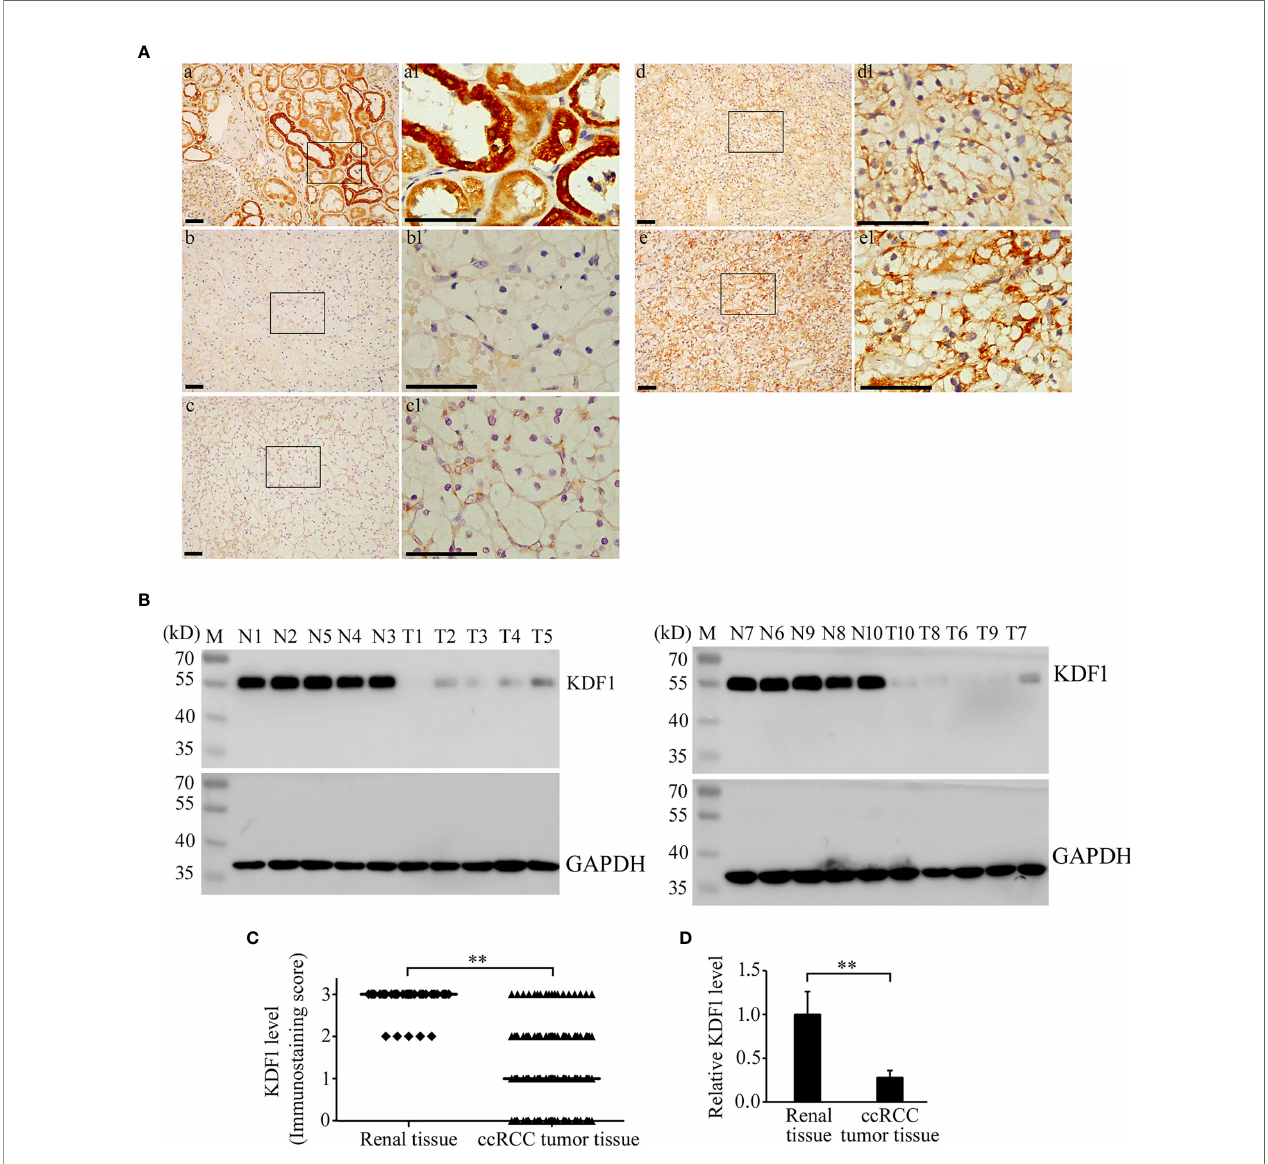
FIGURE 2 | Expression of KDF1 in the tumor tissue of patients with clear cell renal cell carcinoma (ccRCC). Immunohistochemical staining was performed on the tumor tissue of 241 ccRCC patients while 39 non-tumor renal tissue samples were used as controls. The expression of KDF1 in the tumor tissue of 10 ccRCC patients was con fi rmed by Western blot while 10 non-tumor renal tissues were used as controls. (A) Representative pictures of immunohistochemistry. a: A representative picture from non-tumor renal tissue; b: A representative picture from ccRCC patients showing negative immunostaining for KDF1 (the KDF1 level was scored as 0); c: A representative picture from ccRCC patients showing weak immunostaining for KDF1 (the KDF1 level was scored as 1); d: A representative picture from ccRCC patients showing medium immunostaining for KDF1 (the KDF1 level was scored as 2); e: A representative picture from ccRCC patients showing strong immunostaining for KDF1 (the KDF1 level was scored as 3). (B) Results of Western blot analysis for KDF1 in the tumor tissue of 10 ccRCC patients and the matched non-tumor tissue. (C) Comparison of the KDF1 protein level between the tumor tissue of ccRCC patients and the non- tumor renal tissue according to the results of immunohistochemistry. (D) Quantitative analysis of the KDF1 protein level in the tumor tissue of 10 ccRCC patients compared with the non-tumor renal tissue according to the results of Western blot. a1-e1 is the local ampli fi cation of a-e respectively. N1-N10: Non-tumor tissue; T1-T10: ccRCC tumor tissue. **P < 0.01. Scale bar: 50 m